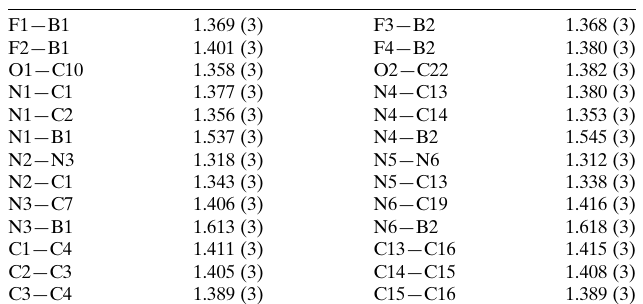
Table 1 Selected bond lengths (A˚ ).